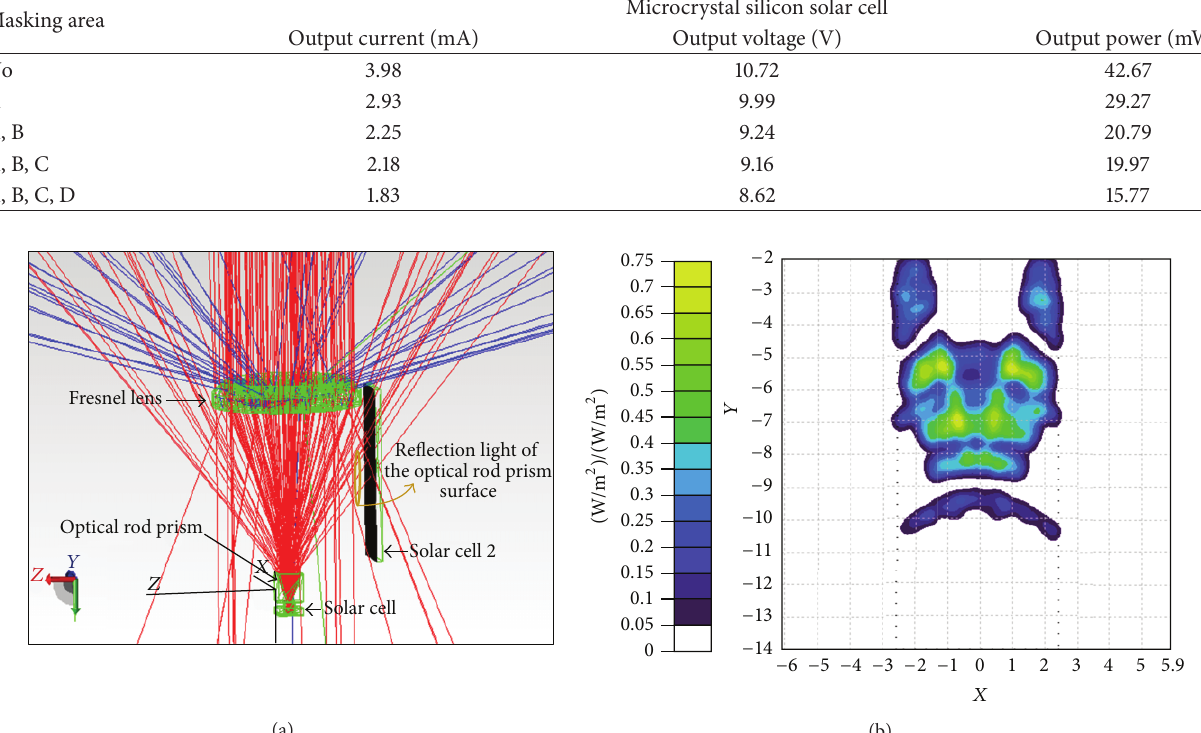
Figure 4: The simulation result derived from the software TRACEPRO which is used to simulate the light trace in mechanism (D).